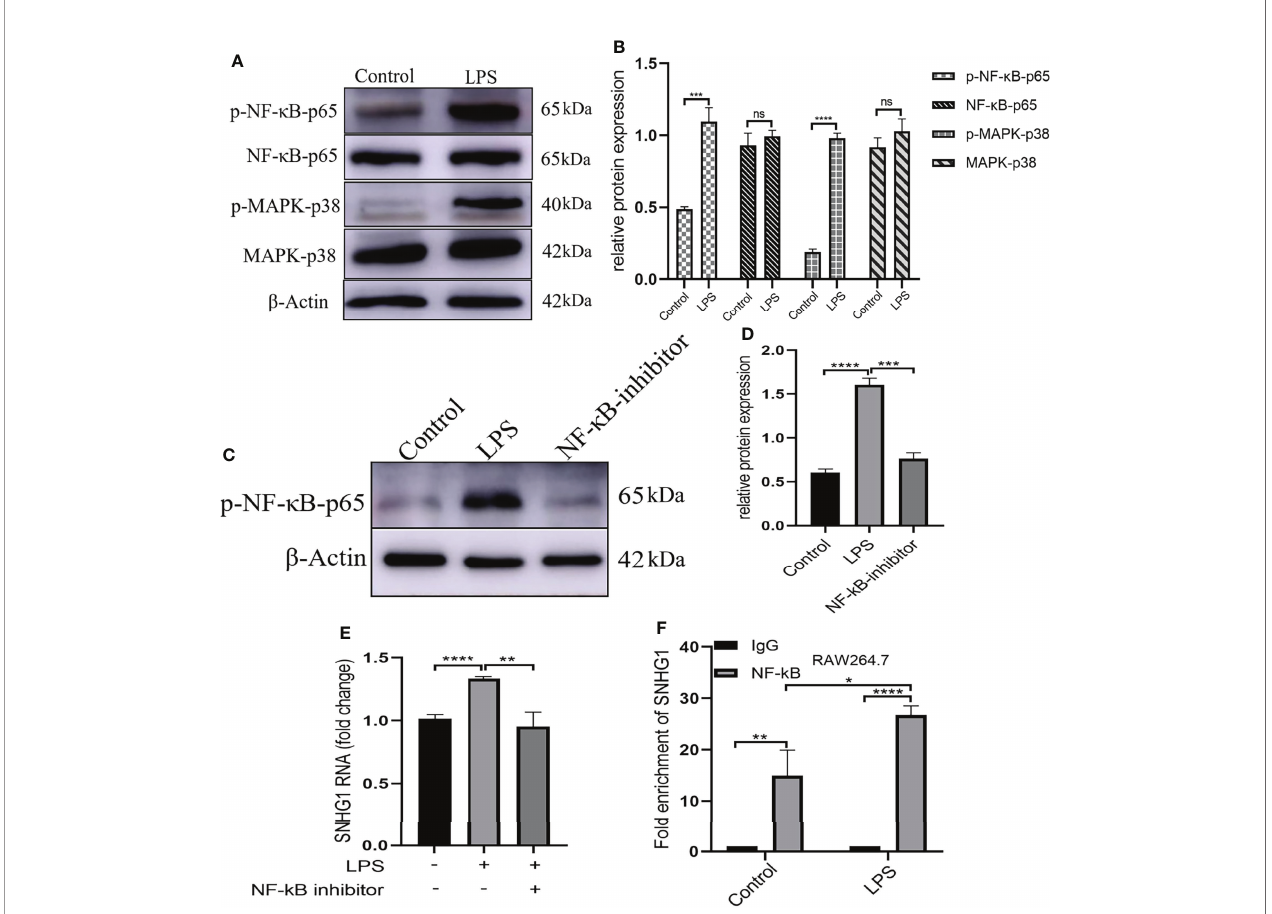
FIGURE 2 | Upstream mediators of SNHG1 expression in macrophages. (A) Relative protein levels of p-NF- k B-p65, NF- k B-p65, p-MAPK-p38 and MAPK-p38 were detected in RAW264.7 cells treated with LPS by Western blot analysis. (B) The gray value of protein expression in the control and LPS groups. (C) Expression of p-NF- k B-p65 in RAW264.7 cells treated with an NF- k B inhibitor (BAY 11-7082) detected by Western blot analysis. (D) The gray value of protein expression in the control, LPS and NF- k B inhibitor groups. (E) The expression of SNHG1 in the PBS, LPS and LPS +NF- k B inhibitor groups. (F) Levels of p65 binding to the SNHG1promoter were determined by CHIP assay and the production of enrichment was determined by qRT-PCR. Data are indicated as the mean ± SD, ns P ≥ 0.05, * P <0.05, ** P <0.01, *** P <0.001, **** P